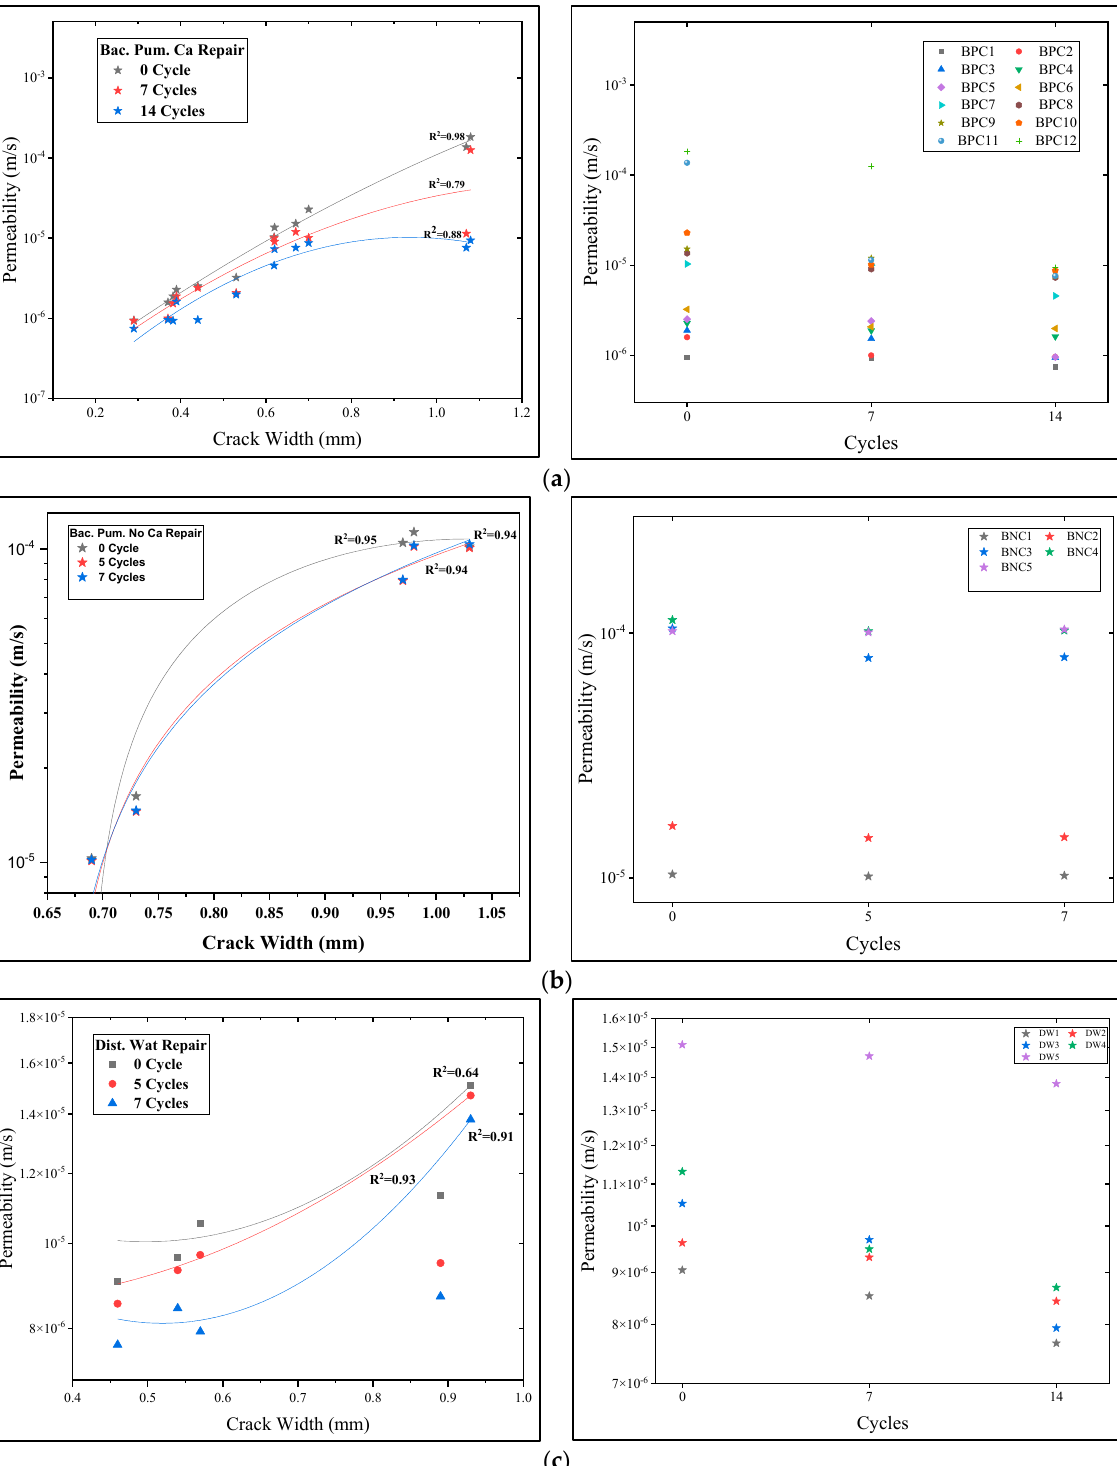
Figure 11. Relationship between repair cycles and permeability. ( a ) Effect of “Bac. Pum. Ca” repair, ( b ) effect of “Bac. Pum. No Ca” repair, ( c ) effect of “Dist. Wat” Repair. Equation (12) was used to assess watertightness using permeability values from various treatments (Supplementary Materials S4). The improved watertightness of the